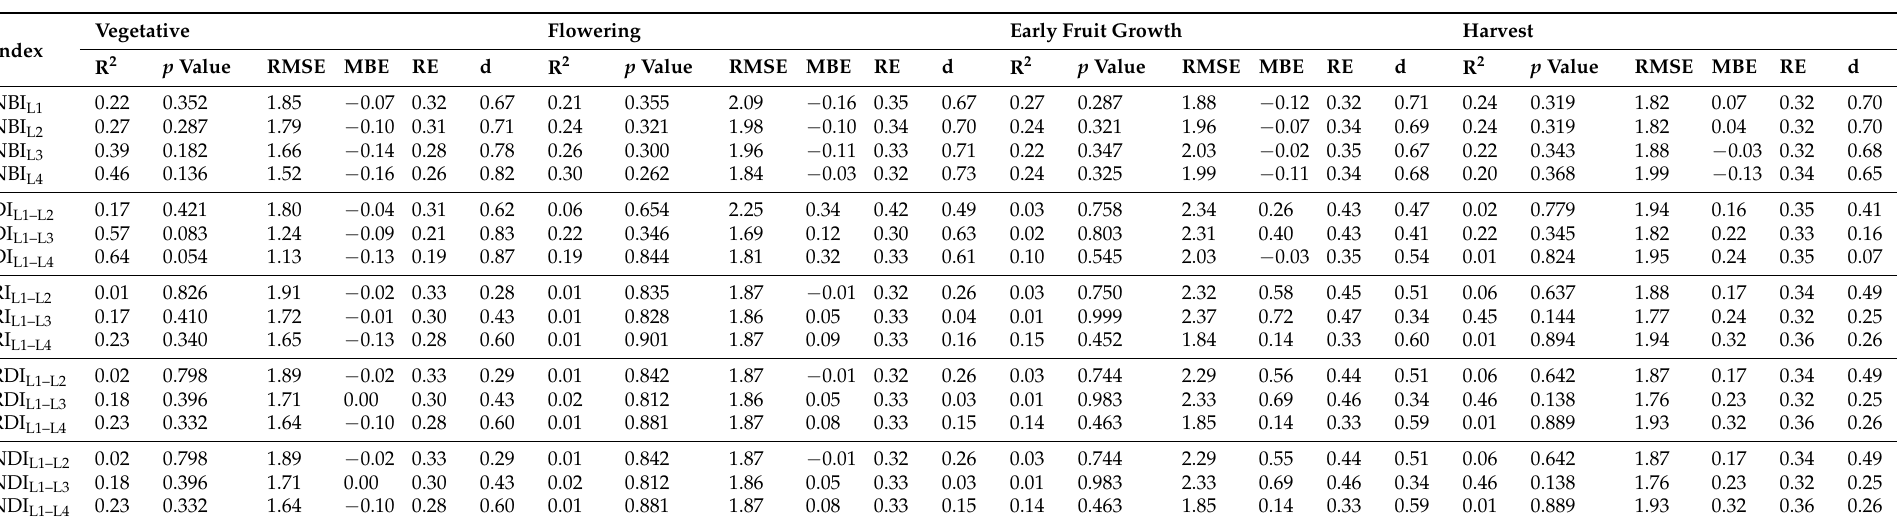
Table 8. Results of the validation analysis of the estimated fruit yield (kg m − 2 ) from NBI measurements and several normalized NBI indices (DI, RI, RDI, NDI), at different phenological stages of muskmelon. DI, Difference Index; RI, Relative Index; RDI, Relative Difference Index; NDI, Normalized Difference Index, R 2 , coefficient of determination; RMSE, root mean square error; RE, relative error; MBE, mean bias error; d, Willmott Index. L 1 , L 2 , L 3 and L 4 , refer to the latest (most recent), second, third and fourth fully expanded leaf,